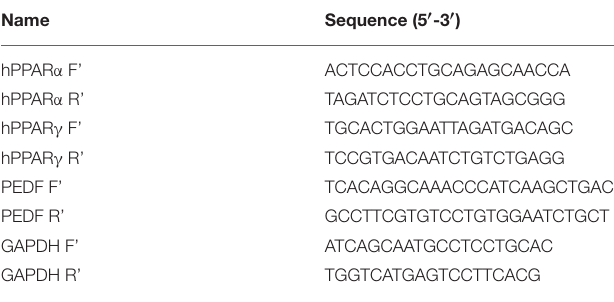
TABLE 1 | Primers used for real-time PCR